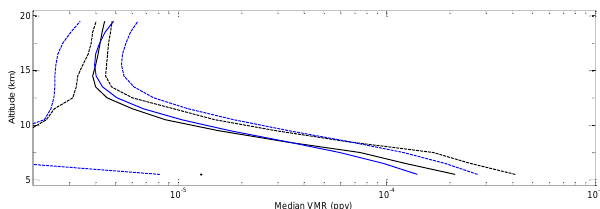
Figure 1. Comparison of global median water vapour volume mix- ing ratios (VMRs) from MAESTRO (blue) and ACE-FTS (black) ( N = 15000). The solid lines are the median profiles, while the dashed lines bracket ± 1.48 median absolute deviations (MAD) about the